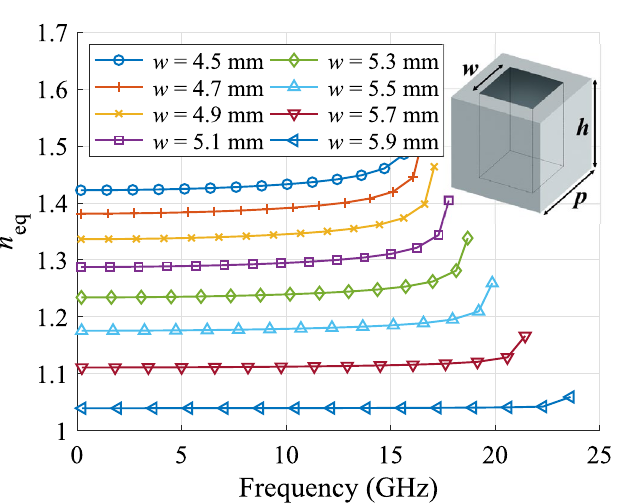
Figure 5. Photograph of ( a ) the H-plane horn lens prototype, and ( b ) the reference H-plane horn prototype.